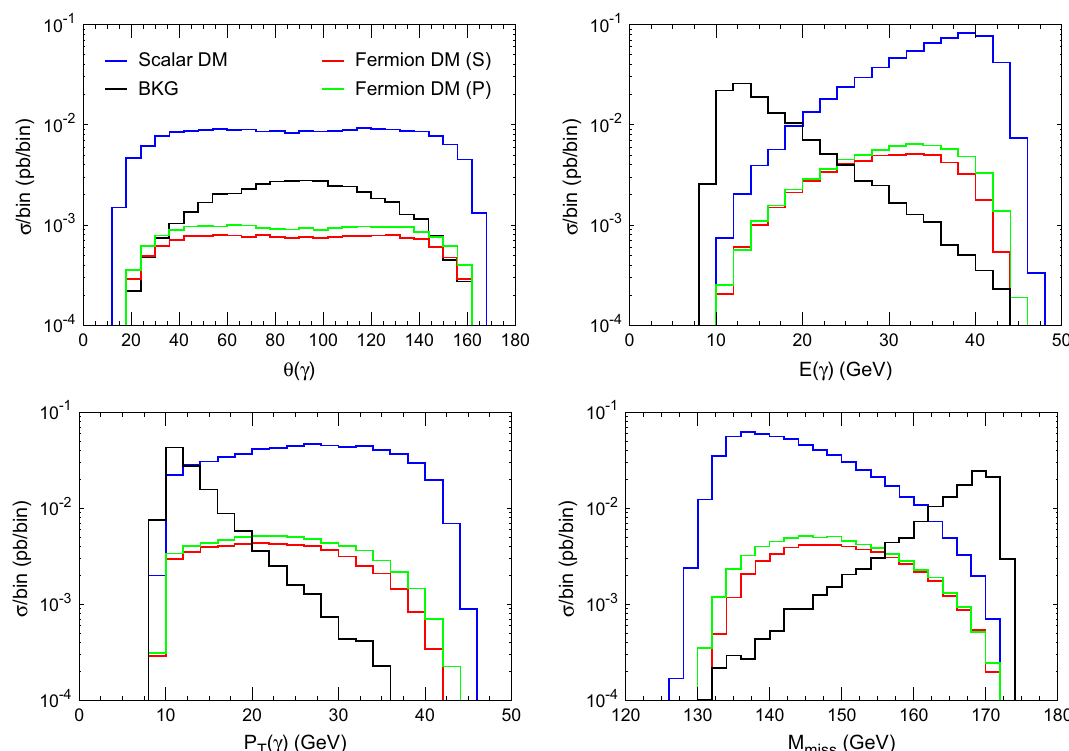
√ s = 91 . 2GeV with Λ = 200GeV at the CEPC with m φ,χ = 10GeV. The background